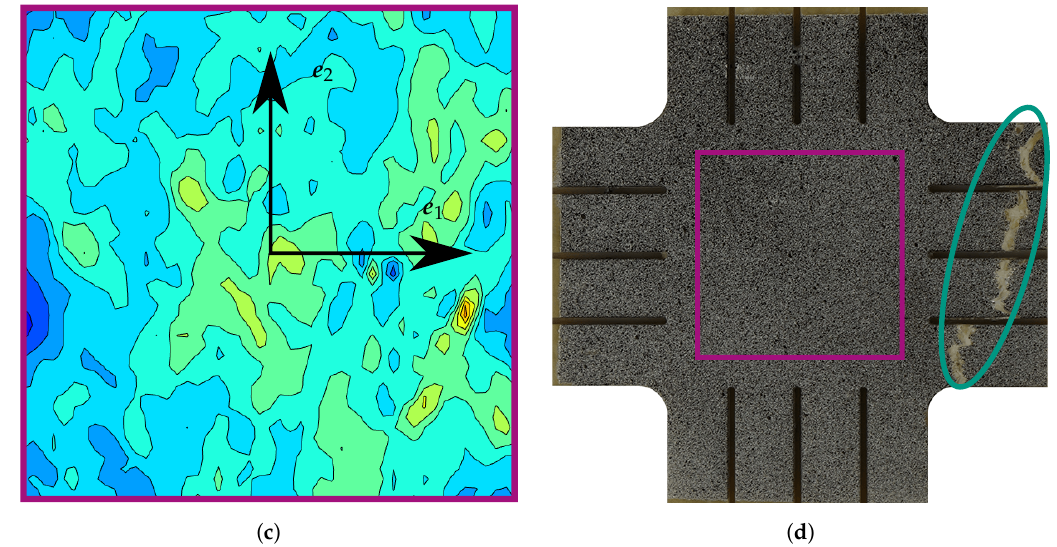
Figure A3. Bonded specimen arms. Last image of strain field before failure and failed specimen.